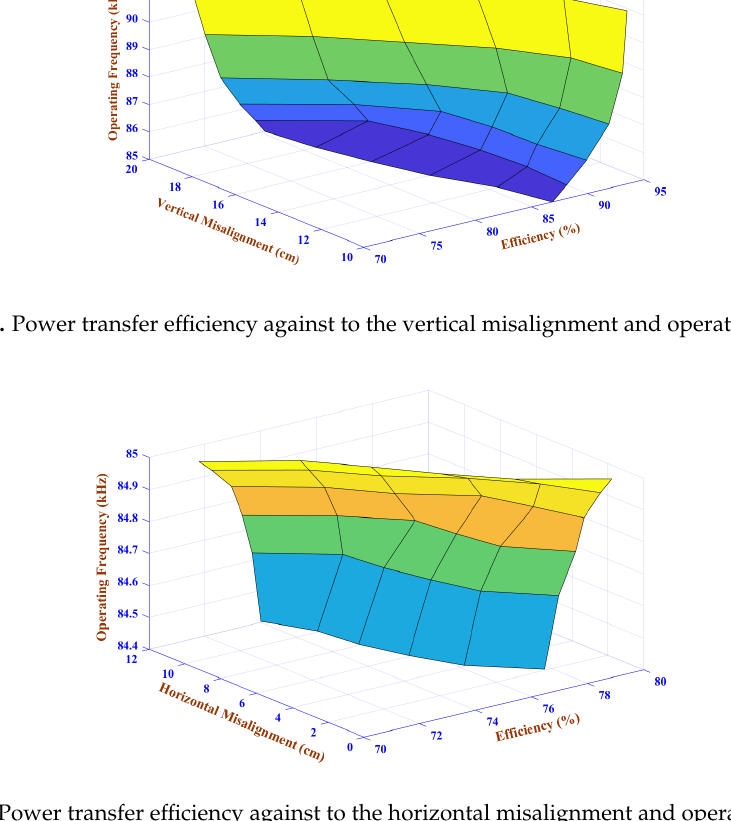
Figure 19. Power transfer efficiency against to the horizontal misalignment and operating frequency. Table 2. Efficiency corresponding to the vertical misalignment under various operating frequencies.